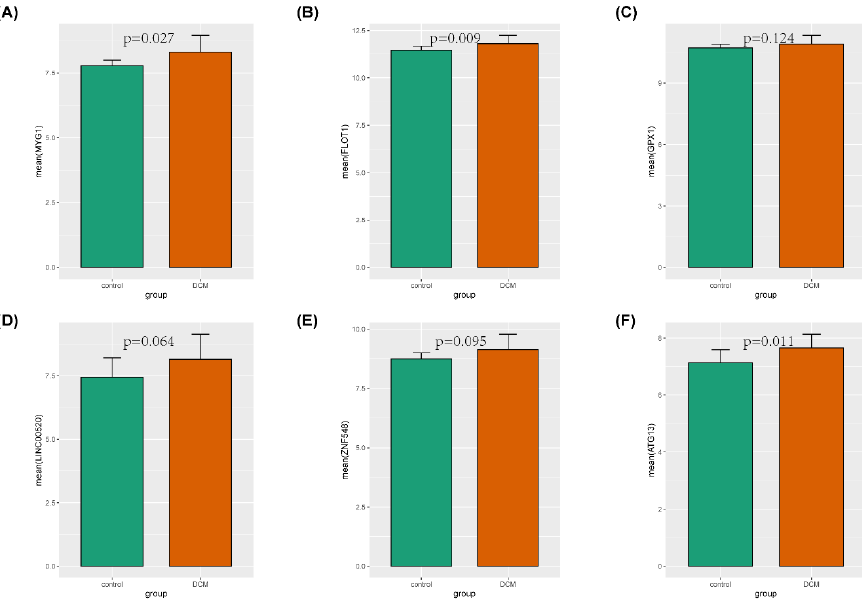
Figure 9. GSE17800 was used to verify the expression levels of hub genes in DCM and control. ( A ) Gene expression values of MYG1 among samples. ( B ) Gene expression values of FLOT1 among samples. ( C ) Gene expression values of GPX1 among samples. ( D ) Gene expression values of LINC00520 among samples. ( E ) Gene expression values of ZNF548 among samples. ( F ) Gene expression values of ATG13 among samples.